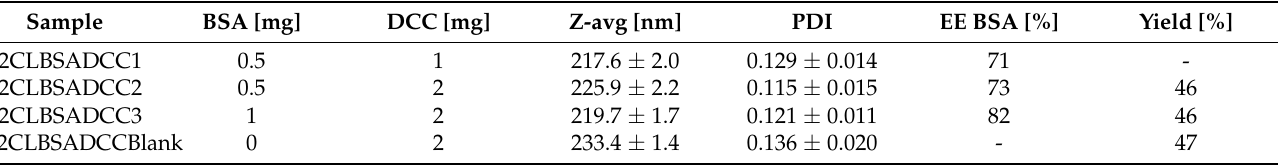
Table 3. Encapsulation of BSA by polymer activation with DCC